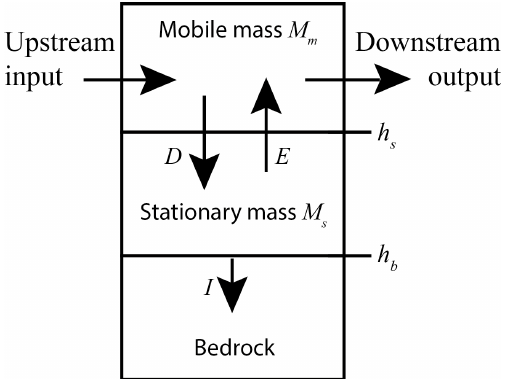
Figure 1. Schematic side view of a control volume within a bedrock channel. The bedrock (bottom) is overlain by stationary sediment (centre), which exchanges particles via entrainment E and deposi- tion D with the mobile sediment in the water column (top). The bedrock surface h b lowers at the incision rate I , while the sediment surface h s evolves according to the balance of entrainment and de- position (Eq.